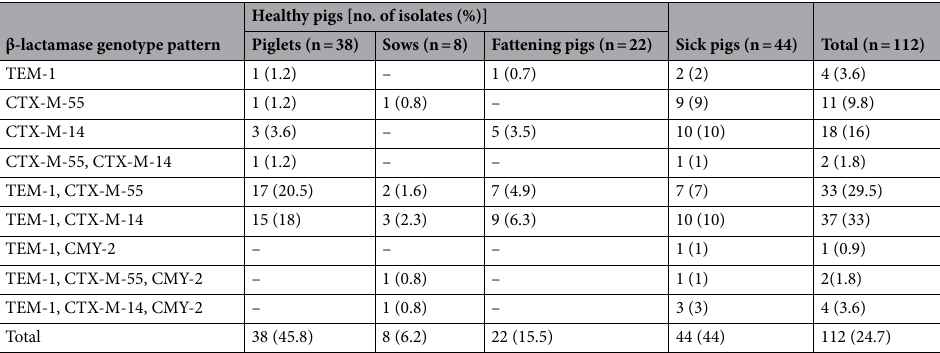
Table 4. Distribution of β-lactamase genes among Escherichia coli isolates from healthy and sick pigs (n = 454) in Thailand between 2007 and 2018.